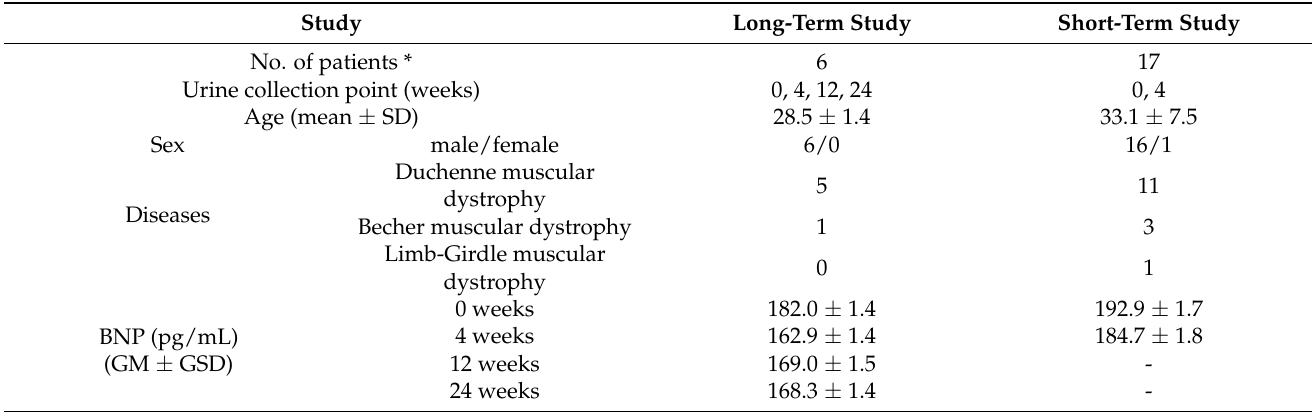
Table 1. Patient characteristics in each study.